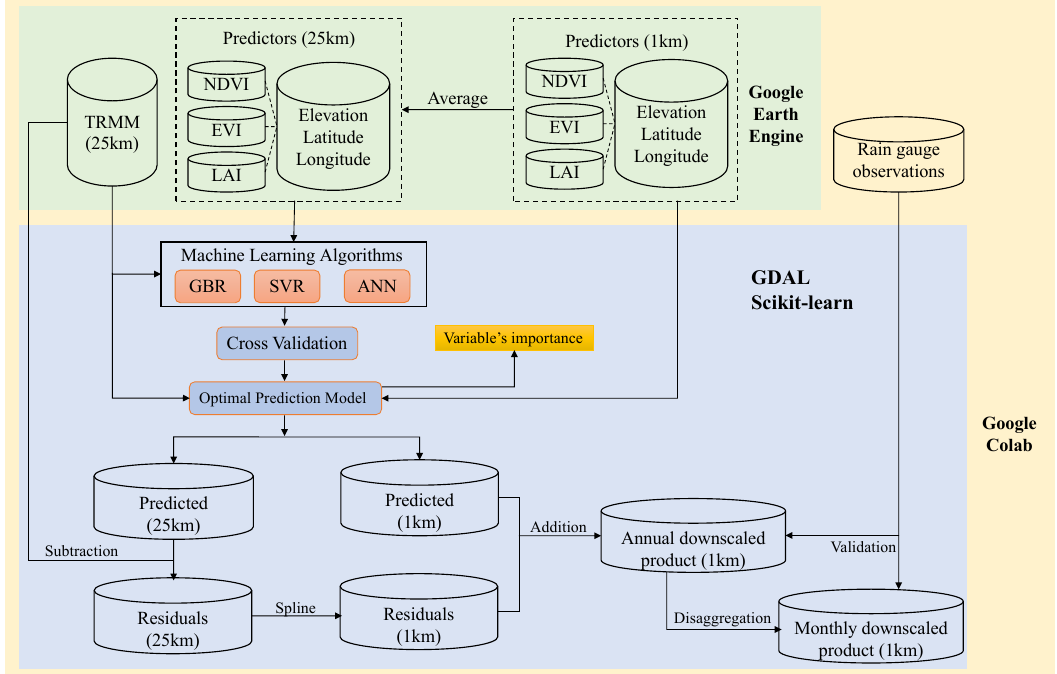
Figure 3. Flowchart of the TRMM downscaling framework through integrating Google Earth Engine and machine learning approaches based on Google Colab.